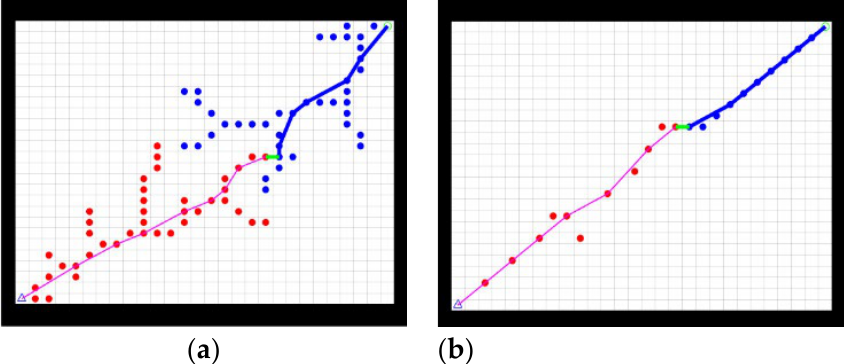
Figure 6. Comparison of two algorithms in obstacle-free environment. ( a ) Traditional bidirectional RRT* algorithm, ( b ) Improved bidirectional RRT* algorithm.